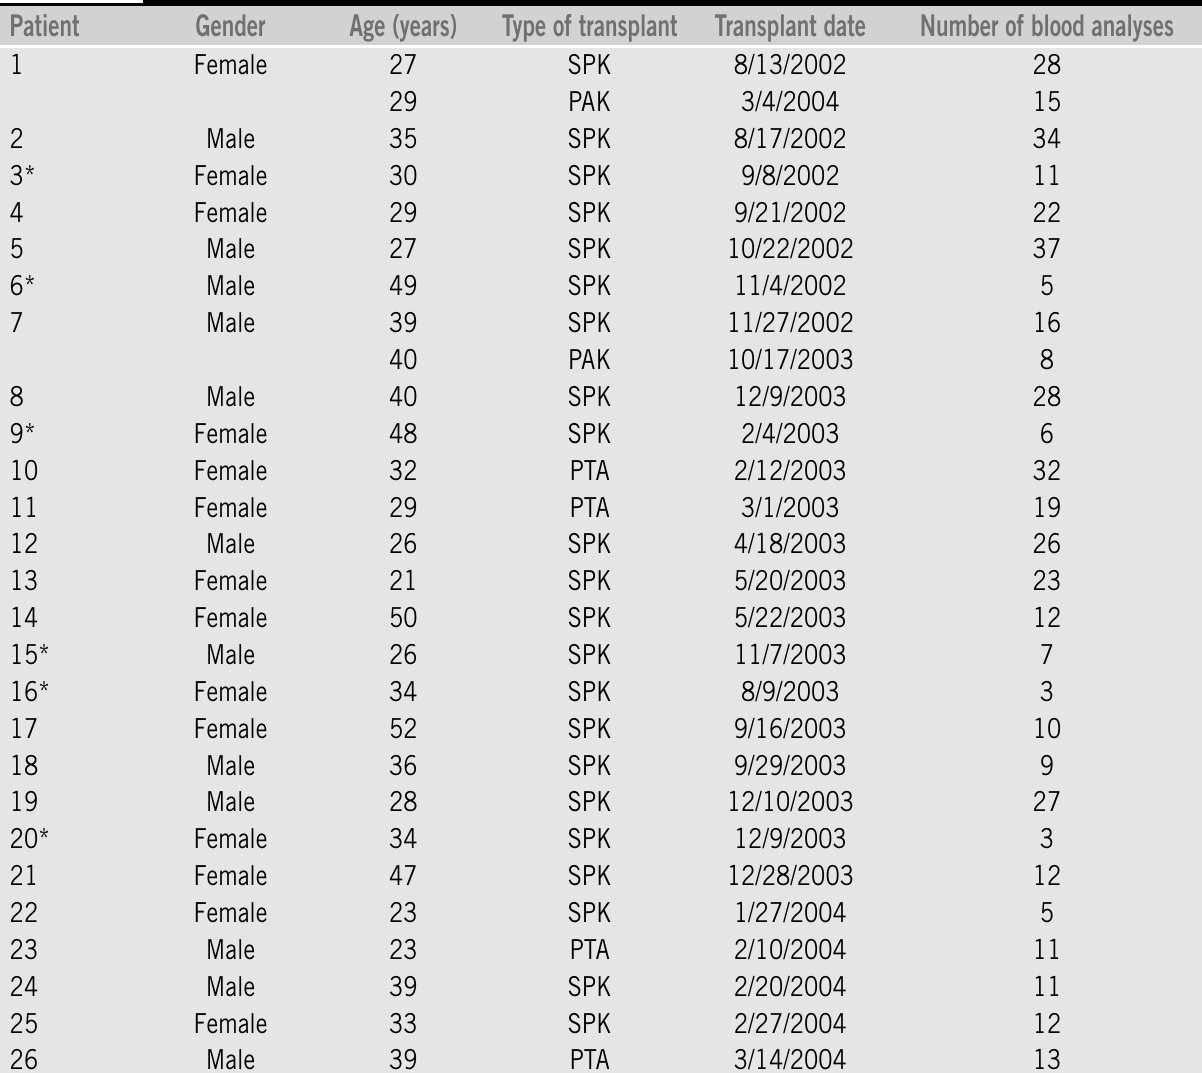
Table 1 Patients’ data: gender, age, type of transplant and date, number of blood analyses Patient Gender Age (years) Type of